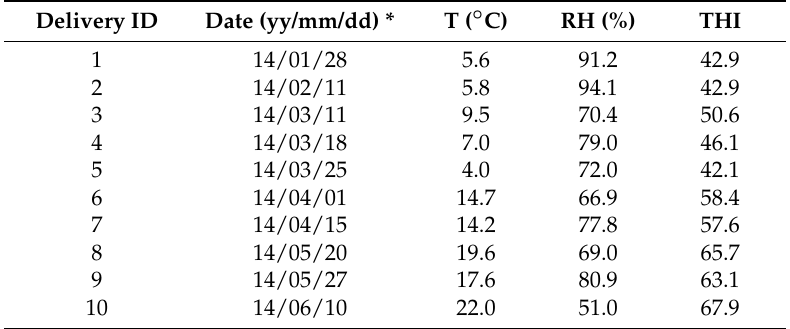
Table 1. Identification (ID) and date of deliveries and outdoor temperature (T), relative humidity (RH) and Temperature Humidity Index (THI) recorded at unloading. The sensor was located close to the platform crossed by the pigs to reach the resting area.